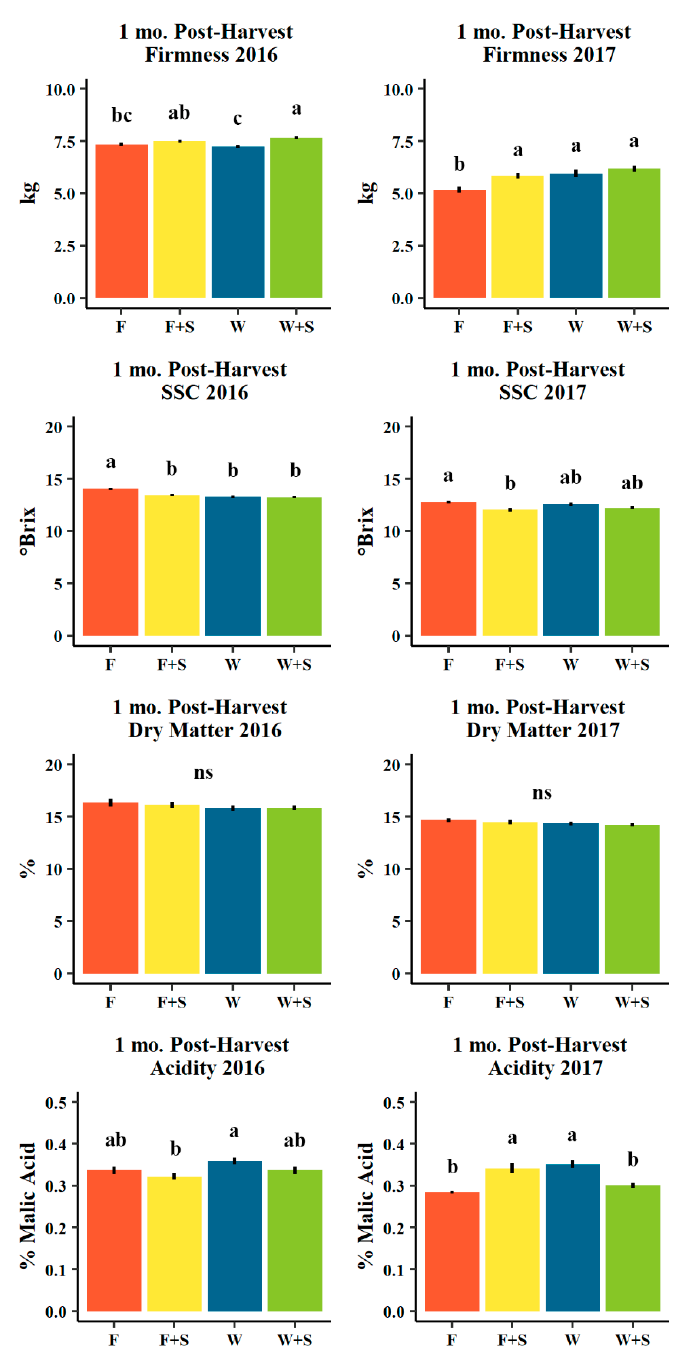
Figure 7. Mean firmness (kg, n = 487 and 350 in 2016 and 2017, respectively), soluble solids content (SSC, °Brix, n = 487 and 347 in 2016 and 2017, respectively), destructively measured actual dry matter (%, n = 108 and 233 in 2016 and 2017, respectively). and acidity (% malic acid, n = 64 and 60 in 2016 and 2017, respectively) for d’Anjou fruit evaluated one mo. post-harvest (within one month after harvest in cold storage plus seven days of ripening at room temperature) in 2016 ( left ) and 2017 ( right ) among seasonal pruning treatments consisting of fall pruning (F, orange), fall and summer pruning (F + S, yellow), winter pruning (W, blue), and winter and summer pruning (W + S, green). Error bars indicate ± standard error. Di ff erent letters indicate significance di ff erence among means ( p < 0.05, Tukey HSD). “ns” indicates no significant di ff erence among means ( p > 0.05, Tukey HSD).